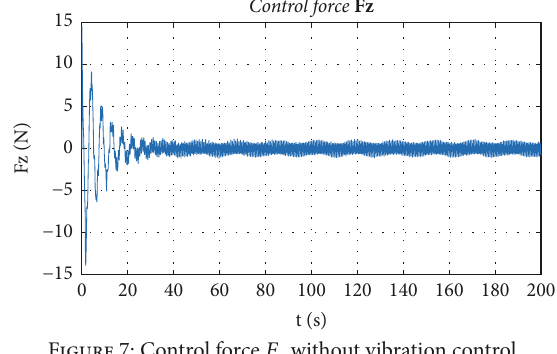
Figure 7: Control force 𝐹 𝑧 without vibration control.